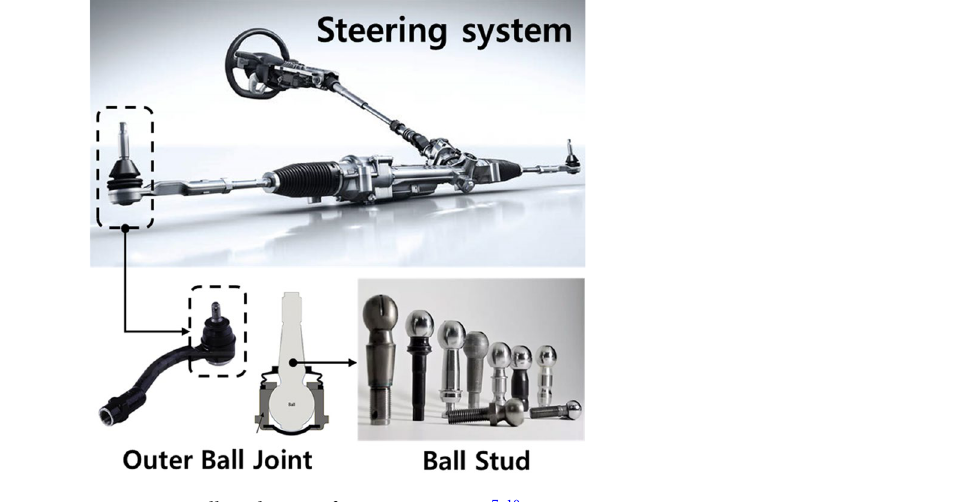
Figure 1. Ball stud parts of a steering system 7–10 .